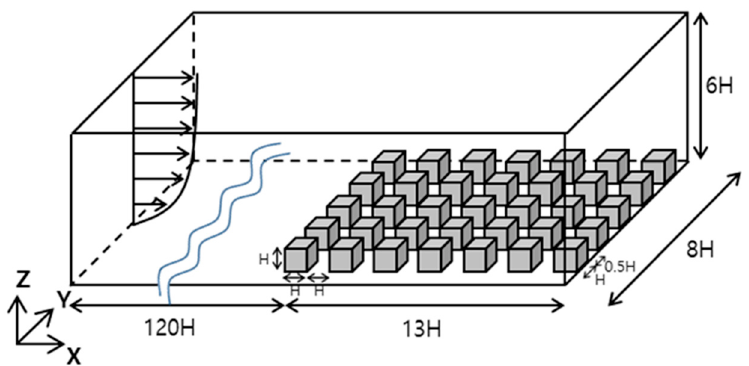
Figure 2. Configuration of the computational fluid dynamics (CFD) computational domain and building blocks arrangement. H denotes the building height.